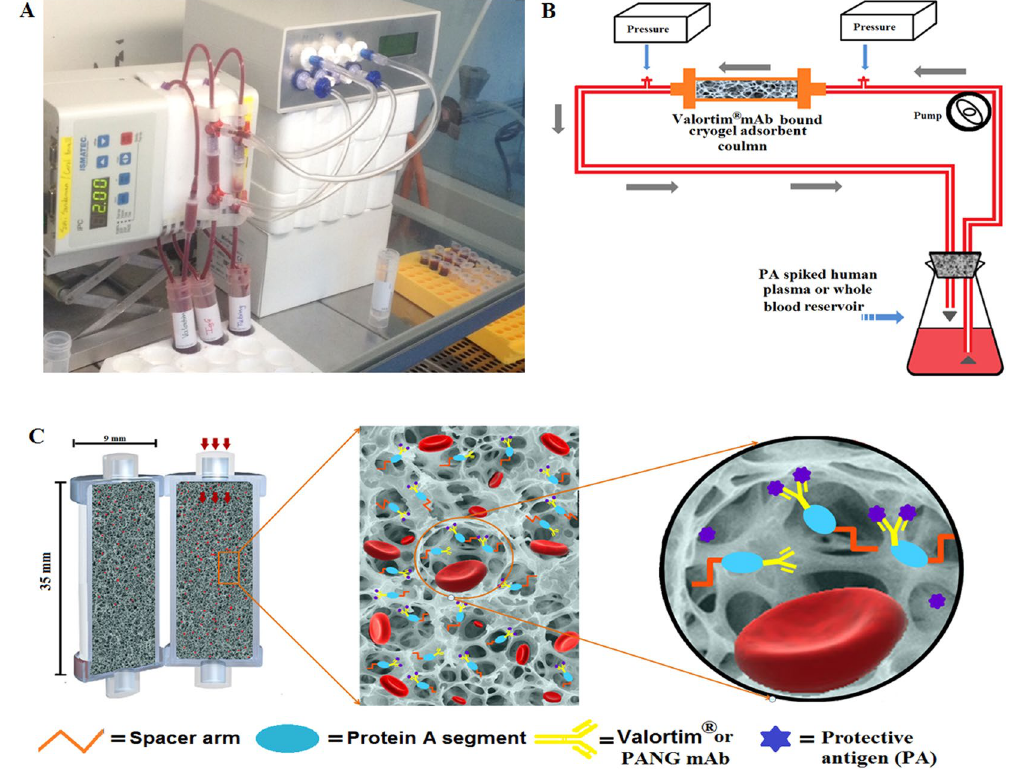
Figure 3. ( A ) Lab scale in vitro experimental setup for the circulation of PA-spiked whole blood (from healthy donors). ( B ) A schematic representation of the in vitro circuit utilized for blood perfusion studies. ( C ) Vertical cross section of cryogel adsorbent column sitting in a plastic casing and cartoon illustration displaying antibody-antigen interactions inside interconnected porous cryogel structure. The adsorbent device is disposable, consisting of antibodies covalently coupled to the cryogel surface through protein-A which is located throughout the interconnected pores. Anthrax protective antigen in the blood is transported via convection and diffusion through the 10–100 μ m pores in the cryogel matrix where they are